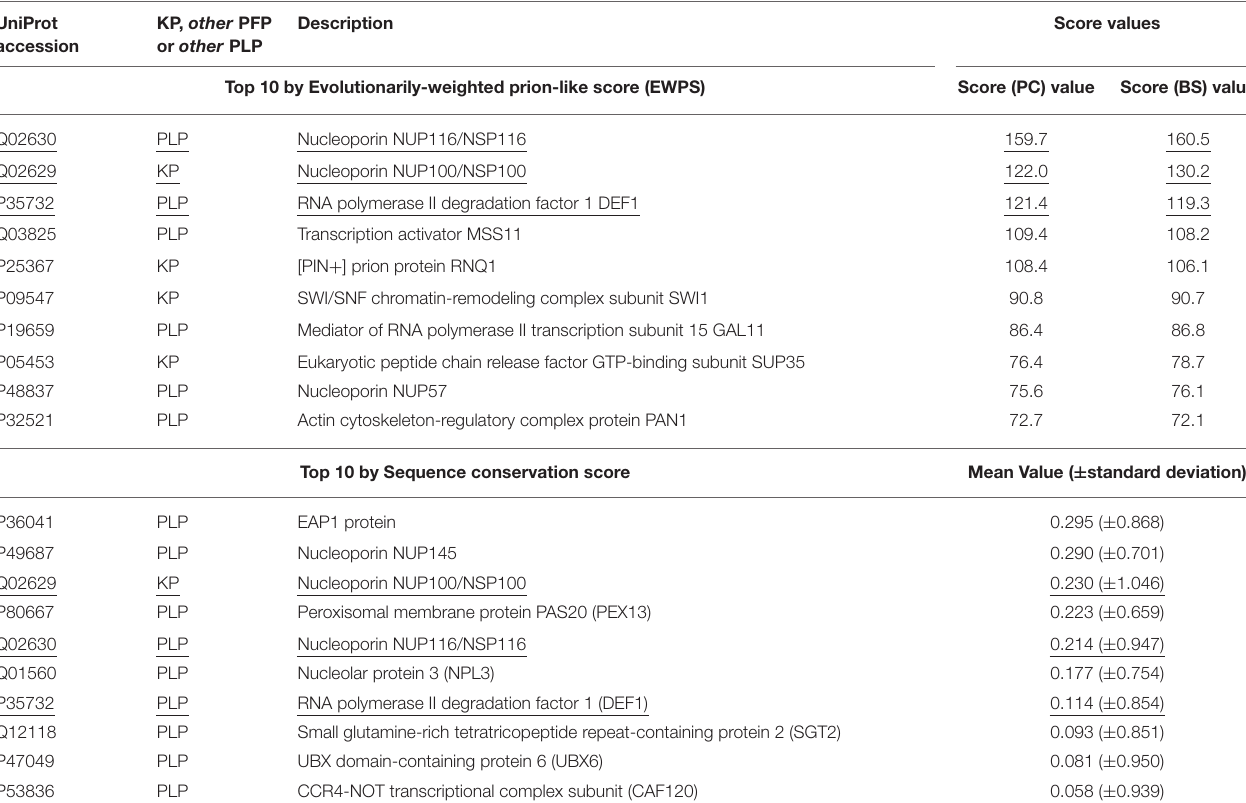
TABLE 1 | Top 10 prion-like or prion-forming proteins by conservation across Saccharomycetes of prion-like composition, or of sequence * . UniProt